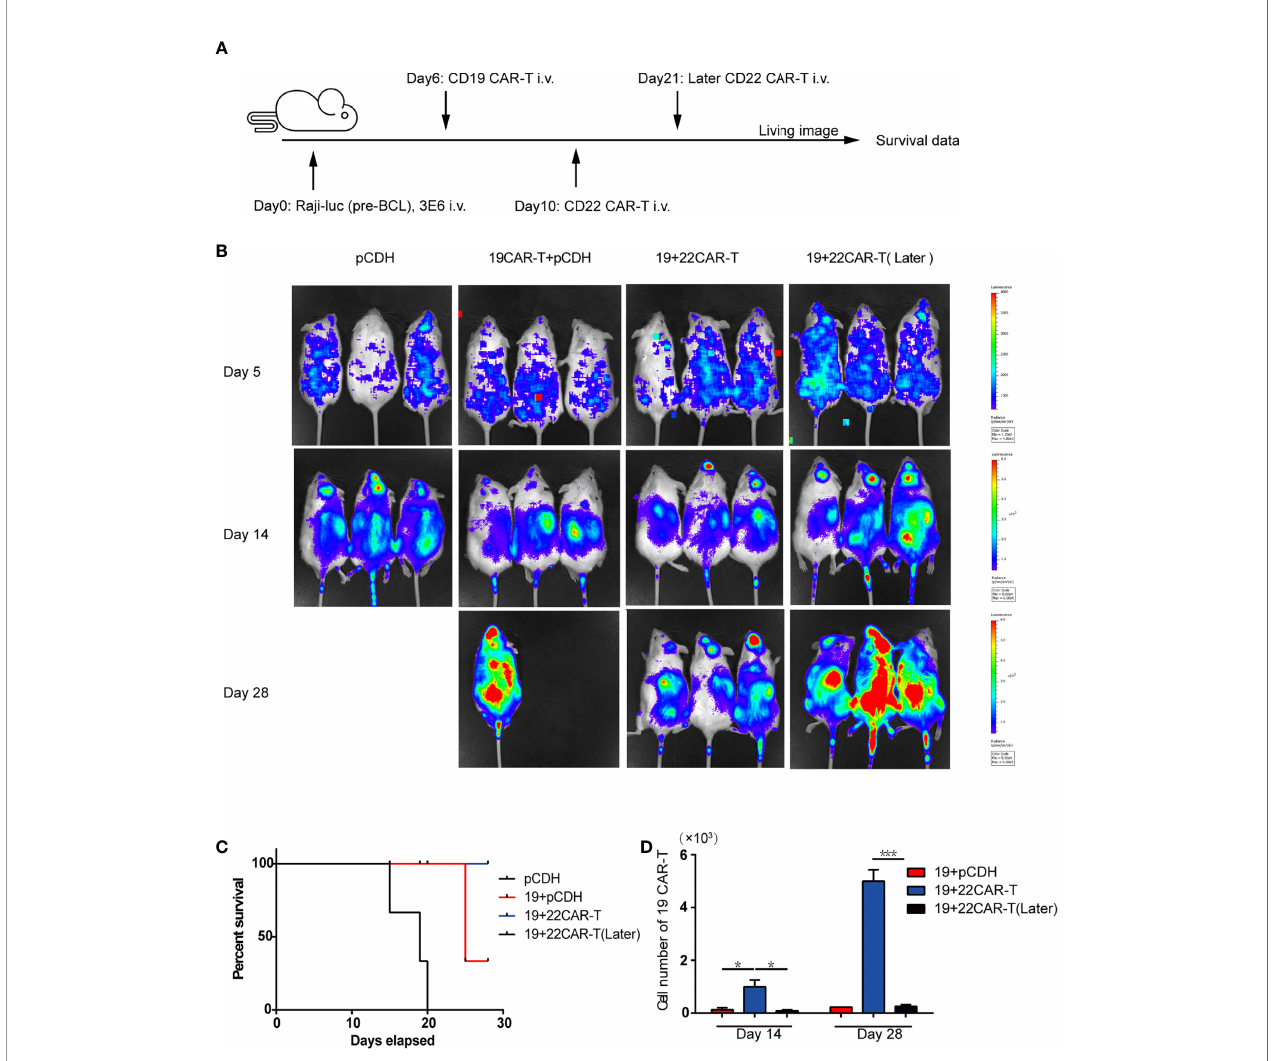
FIGURE 2 | Enhanced antitumor effects after sequential administration of CAR-T cells in vivo. (A) In vivo treatment scheme. (B) Tumor burden measured by bioluminescence. (C) The overall survival. (D) The number of the prior CD19 CAR-T cells was counted before and after secondary CAR-T infusion on days 14 and 28, respectively. *P < 0.05, ***P < 0.001 compared with the control group. Standard error means (SEM) are indicated as error